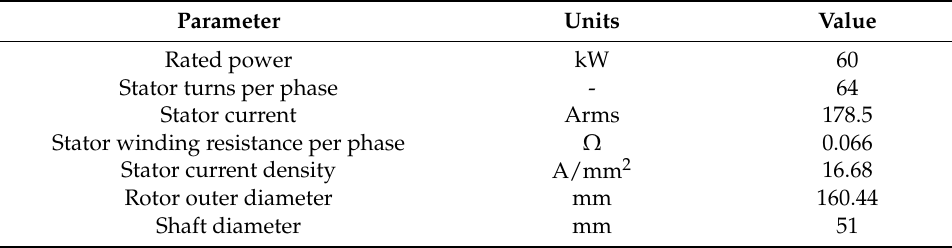
Table 2. Machine model design